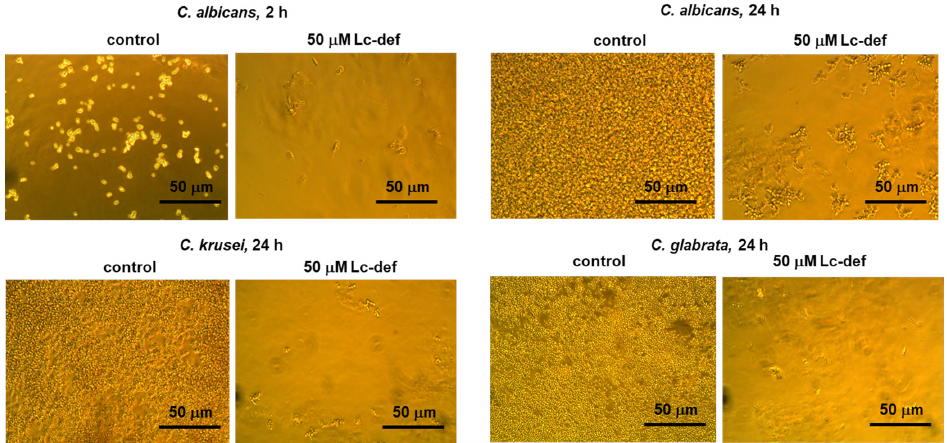
Figure 2. Effects of Lc-def on the growth of the clinical isolates of C. albicans , C. krusei , and C. glabrata (×400 magnification).